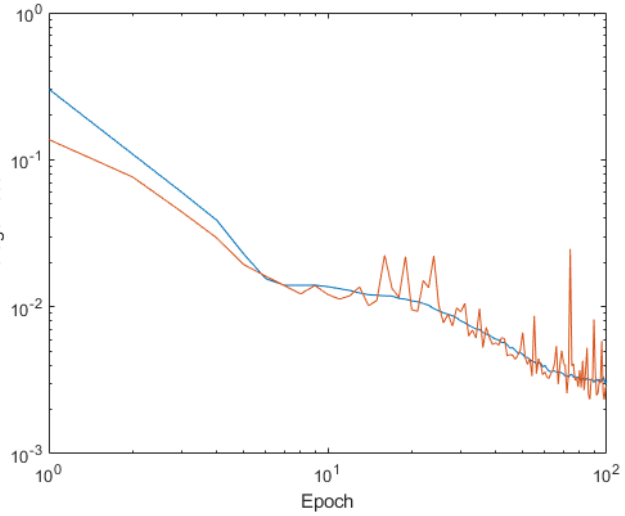
Figure 12. Average loss on training patterns in blue and validation patterns in orange for Standard SGD of Ackley function.